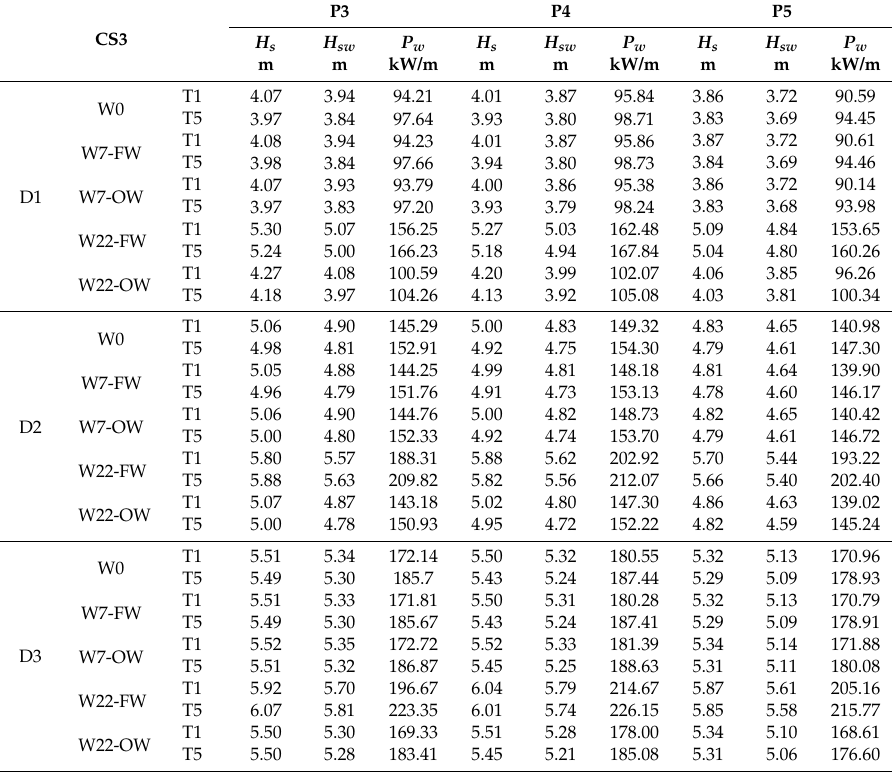
Table 7. SWAN results for CS4, corresponding to the reference points P3, P4, and P5, the tide levels T1 and T5, and the wind conditions W0, W7, and W22, in terms of the wave parameters H s , H sw , and P w .